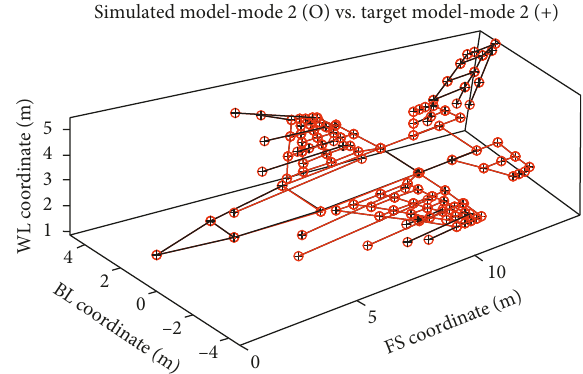
Figure 29: Mode shape for configuration 3